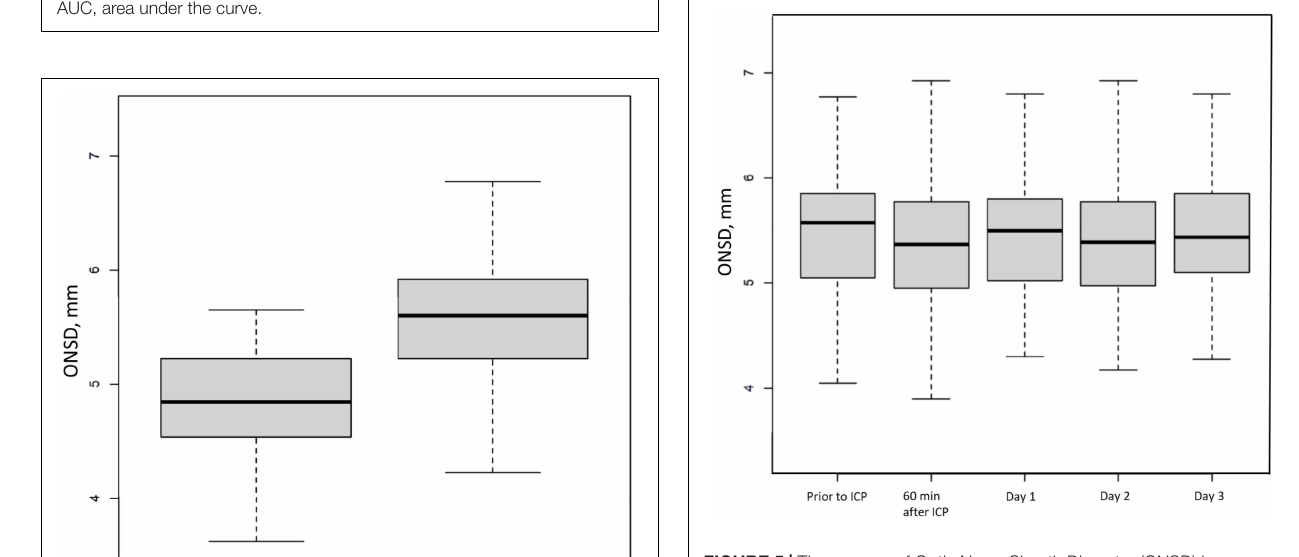
FIGURE 5 | Time course of Optic Nerve Sheath Diameter (ONSD) in a paediatric brain injury population. Box and whisker plots represent interquartile range and 95% CI, respectively, and the horizontal bar indicates the median. ICP, intracranial